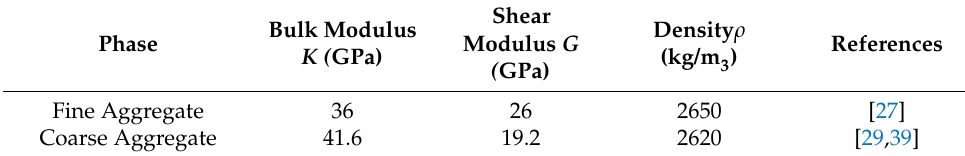
Table 2. Physical parameters of the aggregate.